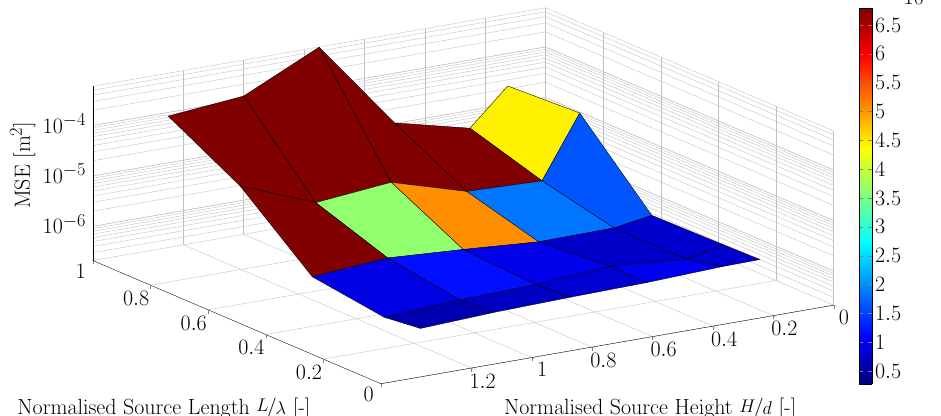
Figure 9. Intermediate water case. Source centre at 2 d of 1.25 d and source length 1